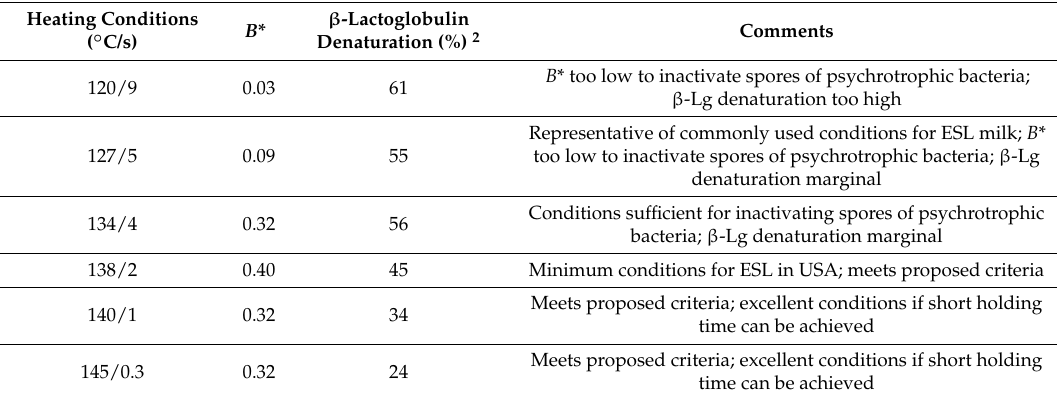
Table 1. Theoretical bactericidal and chemical effects 1 of possible temperature–time combinations for producing ESL